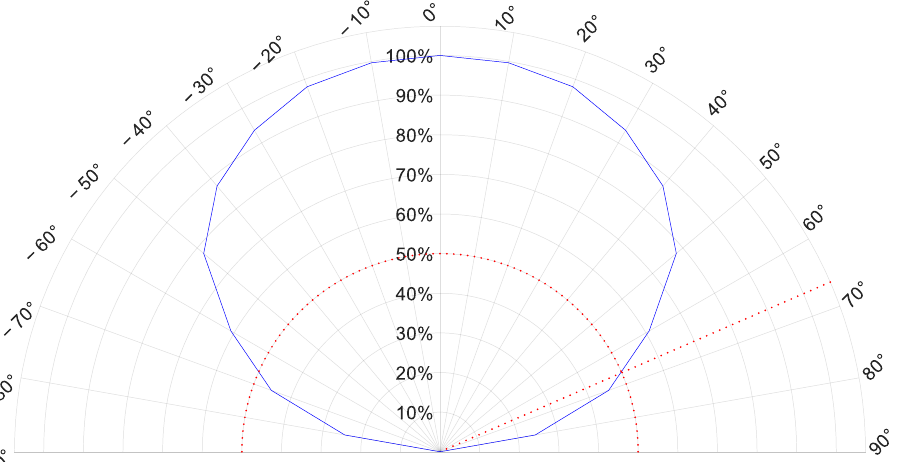
Figure 5. Relative sensitivity [%] versus the angular displacement of the PV module. The semicircle and the segment in red identify the angle of half sensitivity.